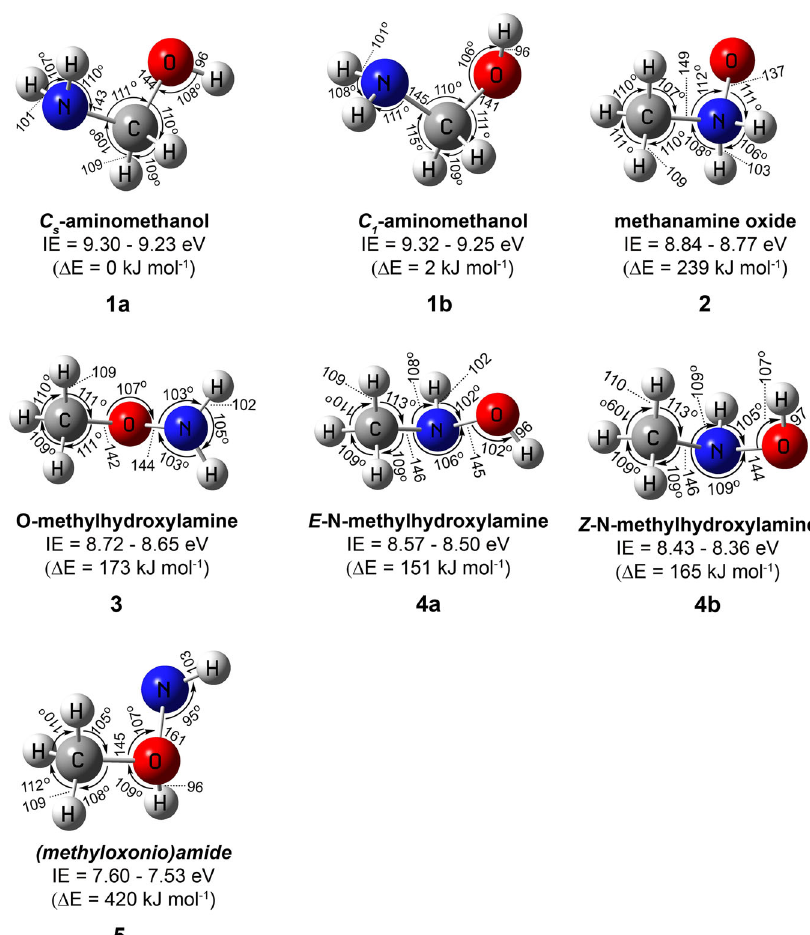
Fig. 2 Structures of CH 5 NO isomers. Ranges of calculated adiabatic ionization energies (IEs) accounting for the error limits and relative energies ( Δ E ) calculated at the CCSD(T)/CBS//CCSD(T)/aug-cc-pVTZ level of theory in eV and kJ mol − 1 , respectively. Geometrical parameters, bond length, and angles are provided in picometer and degrees, respectively. Cartesian coordinates of the structures and their calculated vibrational frequencies are provided in Supplementary Data 1 and 2,